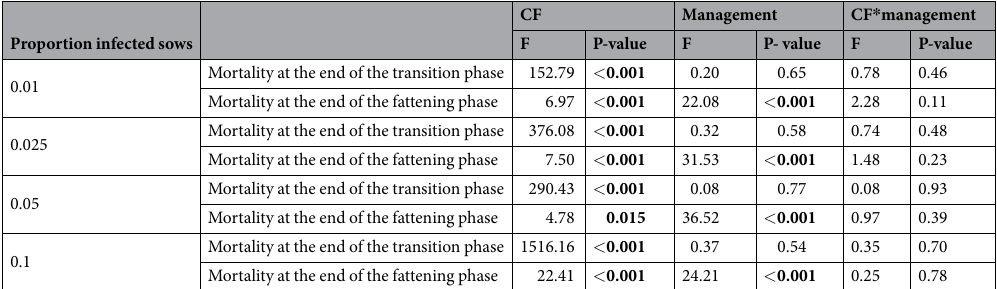
Table 4. ANOVA analysis results on the effect of management during the lactation (cross-fostering), transition and fattening period on mortality at the end of the transition and fattening period. Mortality is calculated as the percentage of dead animals versus the whole population during one period. In bold type appear statistically significant results. CF means cross-fostering. Management refers to orderly or random movements during transition and fattening. F means the statistical contrast